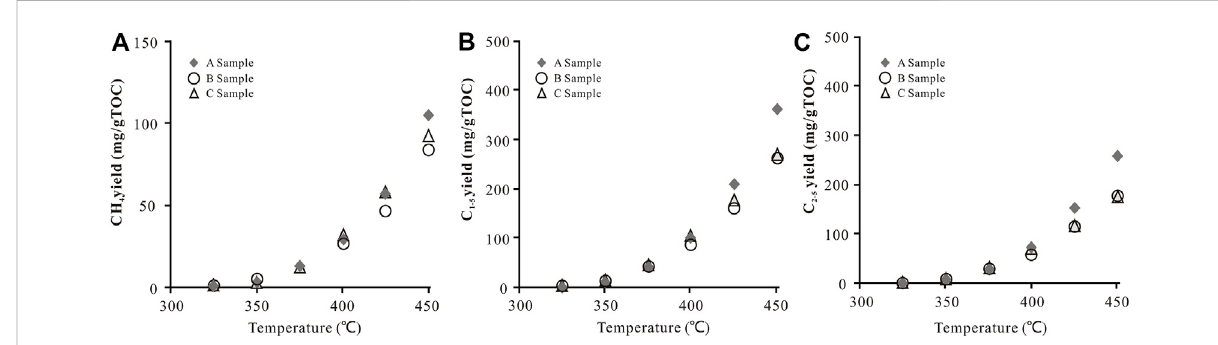
FIGURE 1 Plot of hydrocarbon yield for each series [ (A) : CH 4 yield; (B) C 1-5 yield; (C) C 2-5